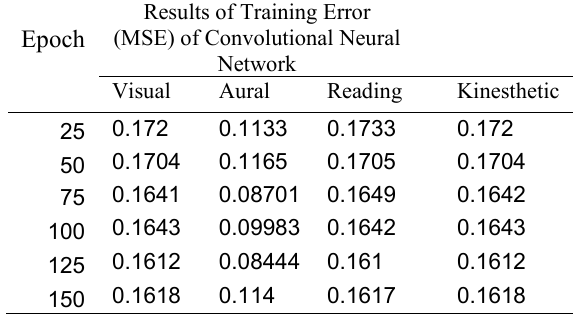
Table 3. Results of Training CNN with Back propagation Algorithm